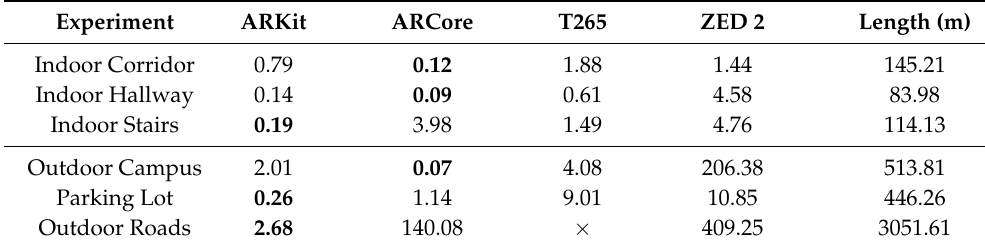
Figure 5. Example images from the indoor and outdoor benchmark datasets. The top row presents three indoor sequences that were traversed by foot, which included long corridors ( a ), open hallway spaces ( b ), and repetitive stairs ( c ) in a university building. We acquired the camera motion data on the outdoor campus on foot ( d ) and in a car in an underground parking lot ( e ) and on urban outdoor roads ( f ). Table 1. Evaluation results (FDE) of the four proprietary VIO